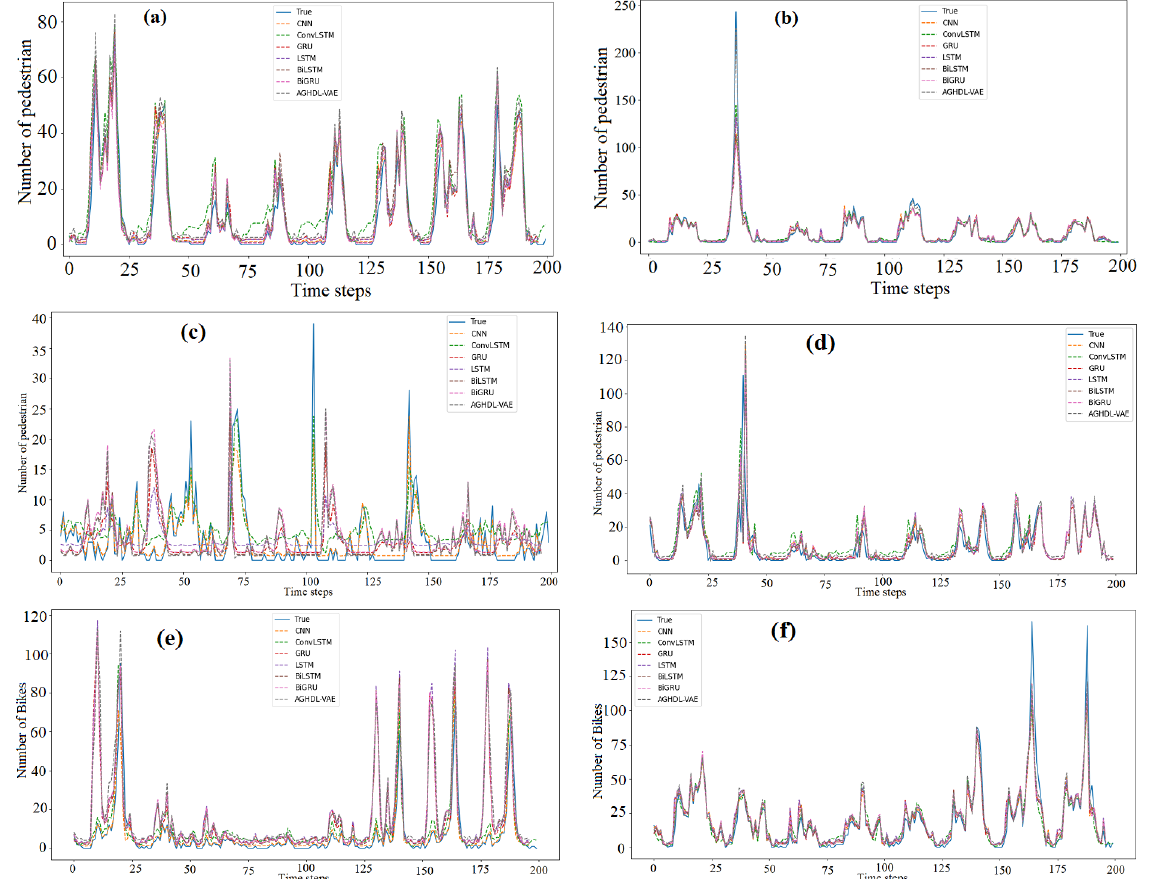
Figure 5. Measured and forecasted, ( a ) Data Set 1, ( b ) Data Set 2, ( c ) Data Set 3, ( d ) Data Set 4, ( e ) Data Set 5 and ( f ) Data Set